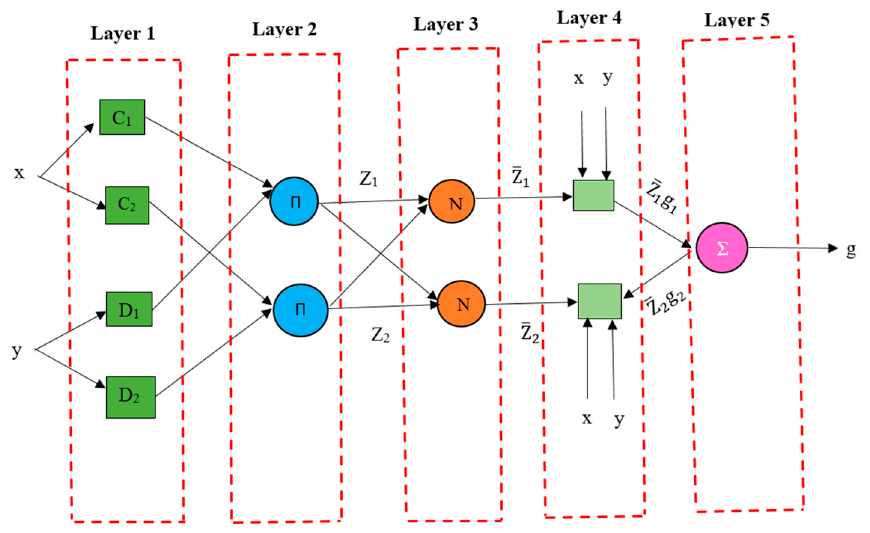
Figure 1. Standard illustration of ANFIS structure.